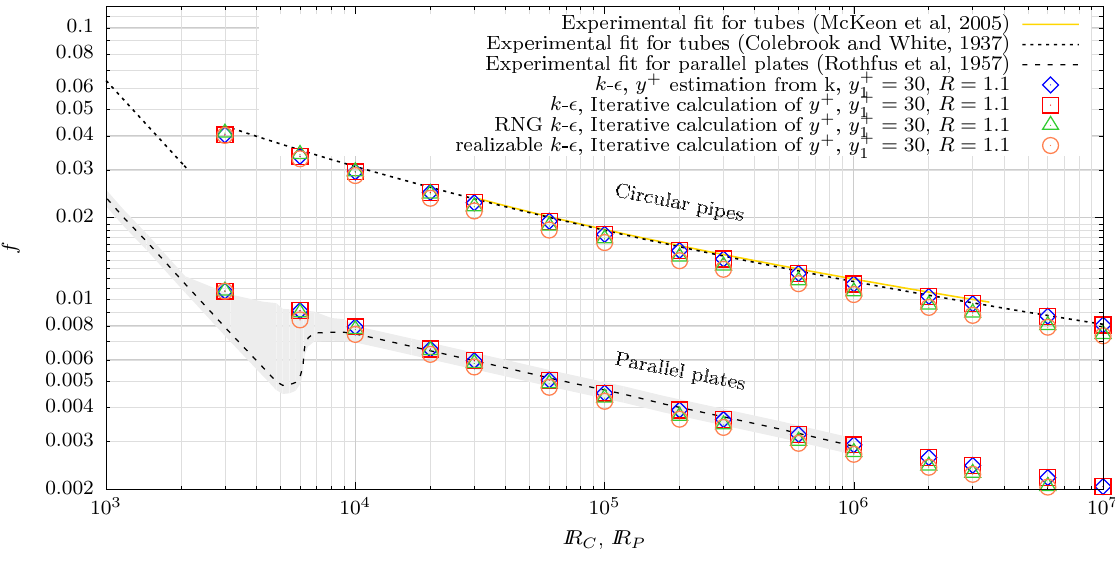
Figure 10: Comparison between friction factor from LWF treatment and from experimental results.